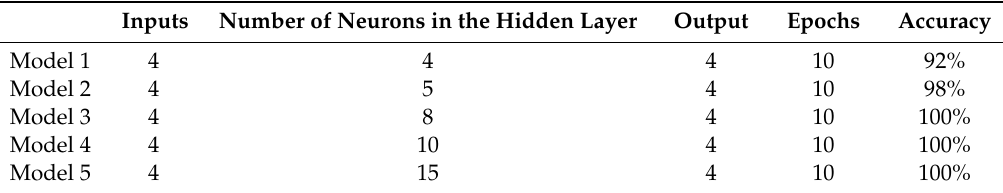
Table 2. RBF-ANN maturity classifier.